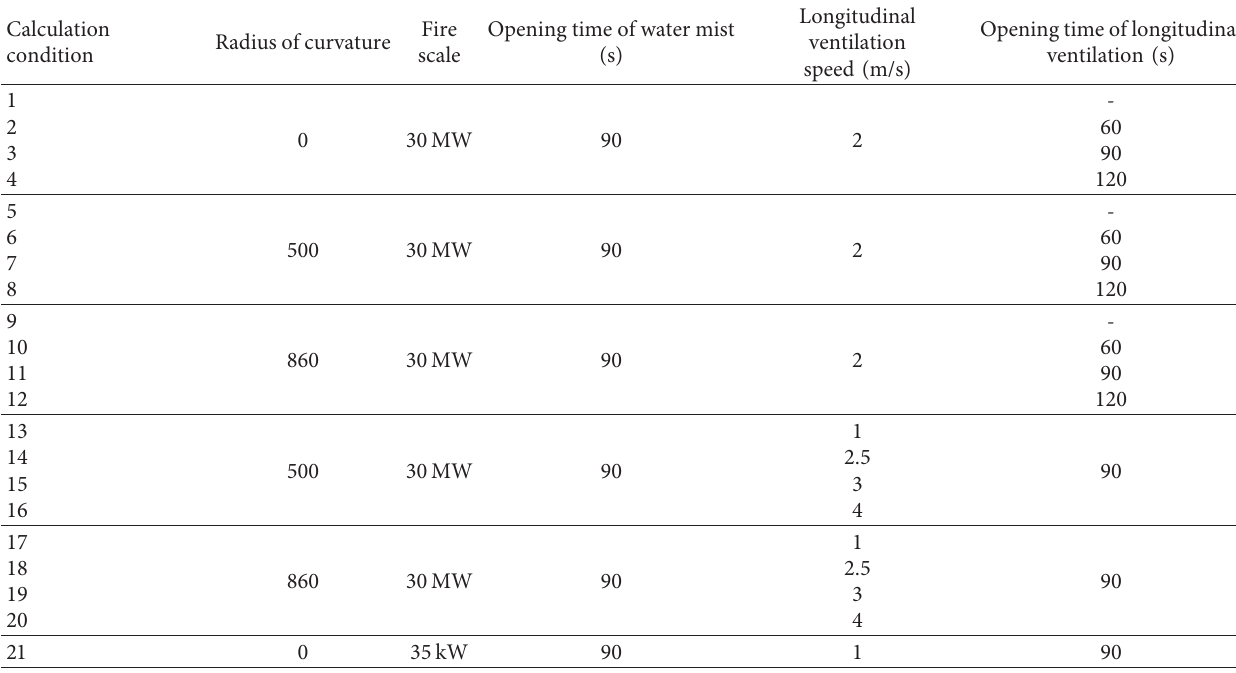
Table 2: Simulation